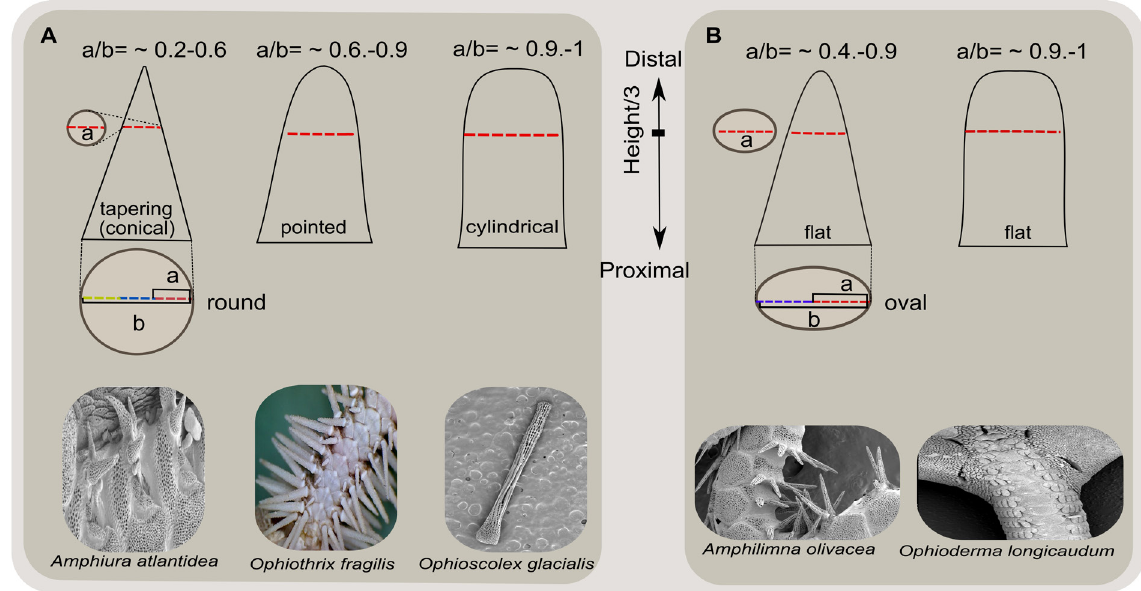
Fig. 5. Typical arm spine shape. A . Tapering (conical): distally ⅓ as thick as proximal diameter with a round cross-section; Pointed: distally half as thick as proximal diameter with a round cross-section; Cylindrical: same thickness at both ends with flat/round tip. B . Flat: distally half as thick as proximal diameter with oval cross-section. Red dashed lines show the ⅓ distal cross-section. The letters ʻaʼ and ʻbʼ illustrate the diameter of ⅓ distal and basal cross-sections, respectively. ʻa/bʼ shows the approximate ratio of these